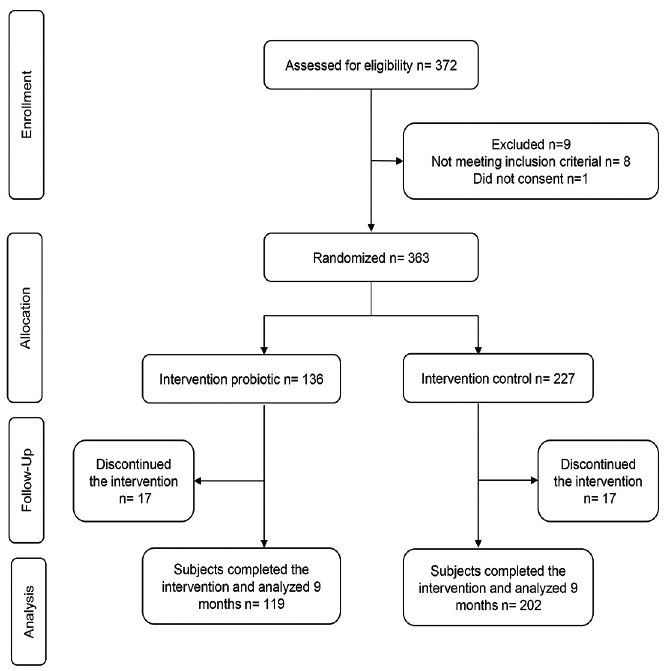
Figure 1- Flow chart of the randomization and attrition of participants throughout the 9-month